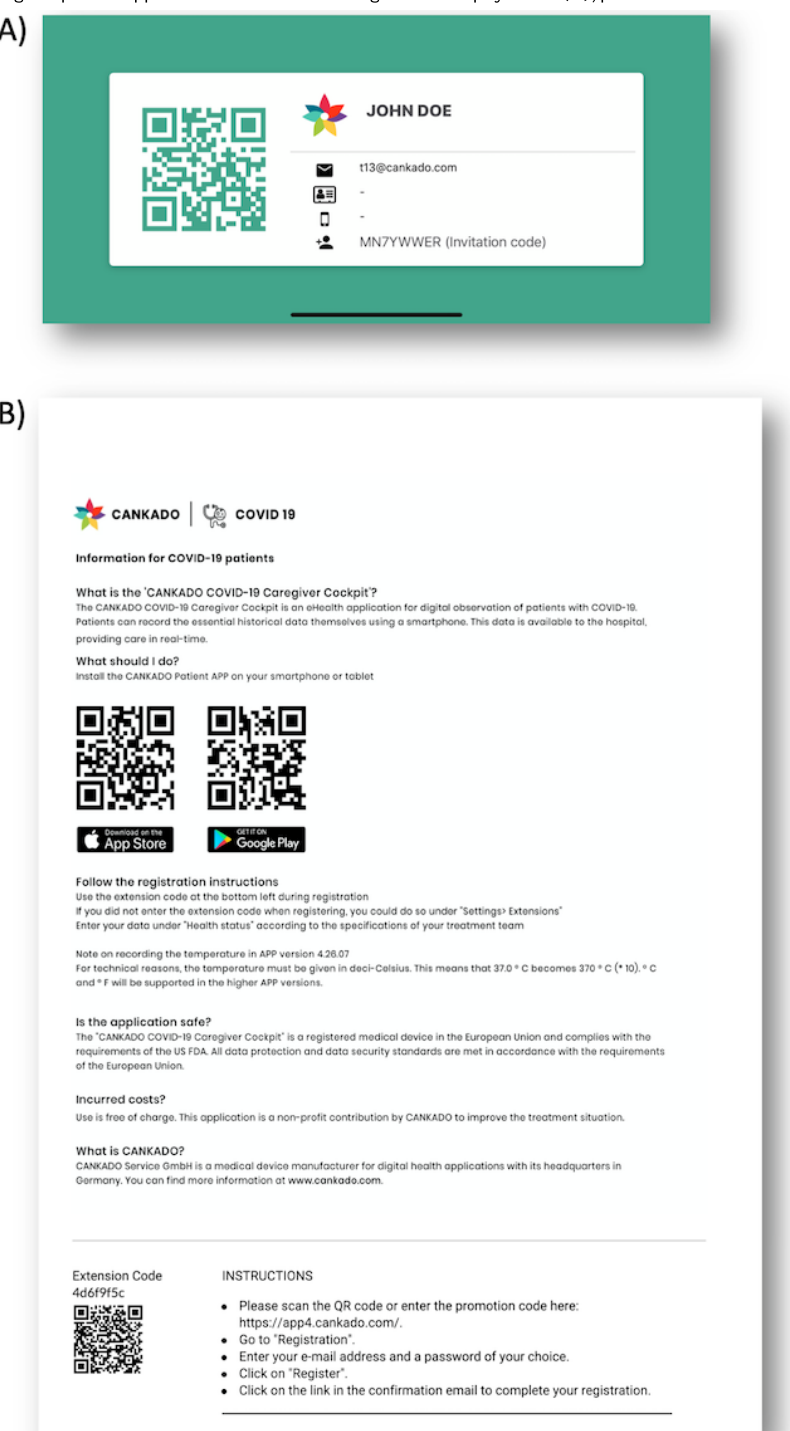
Figure 3. Invitation code using the patient app for a contact-free meeting with their physician (A); patient instruction for self-linking to a center